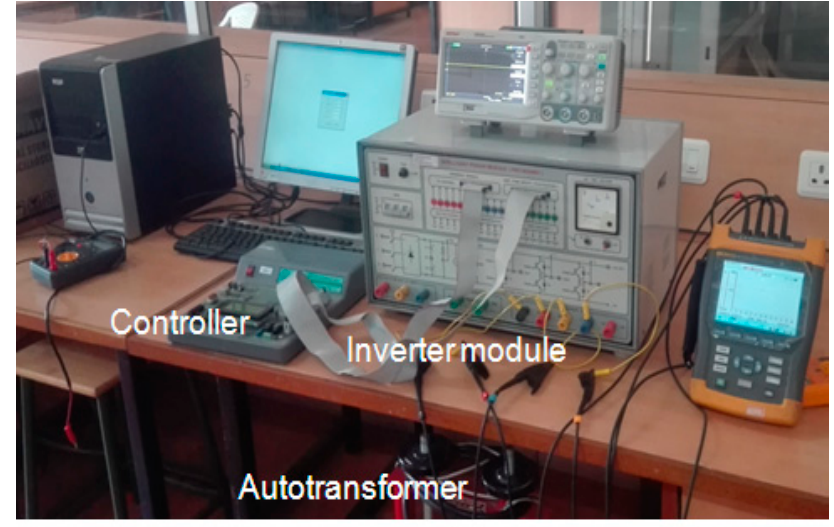
Figure 11. Hardware prototype of the Quasi Z-source inverter (QZSI)-based unified power quality conditioner (UPQC).